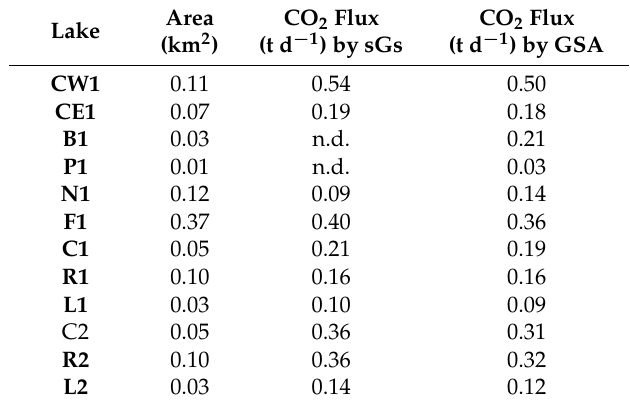
Table 3. Estimated global CO 2 emissions based on two different statistical analyses